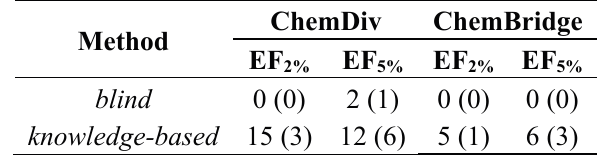
Table 3. EF values at 2% and 5% obtained from docking